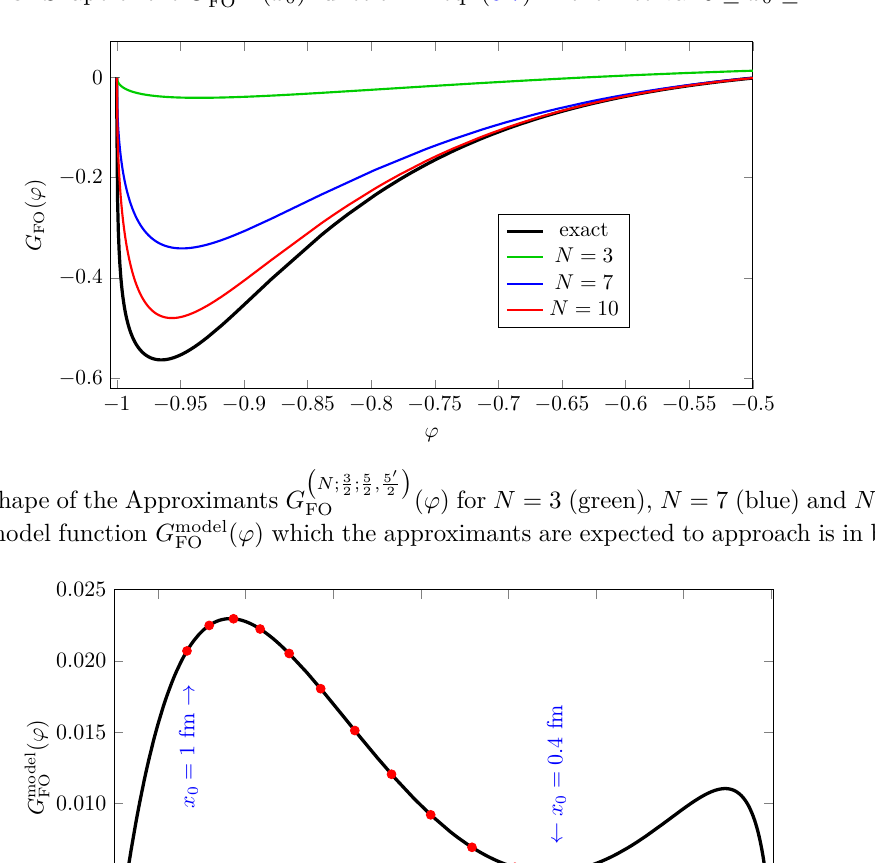
Figure 8 . Shape of the G model